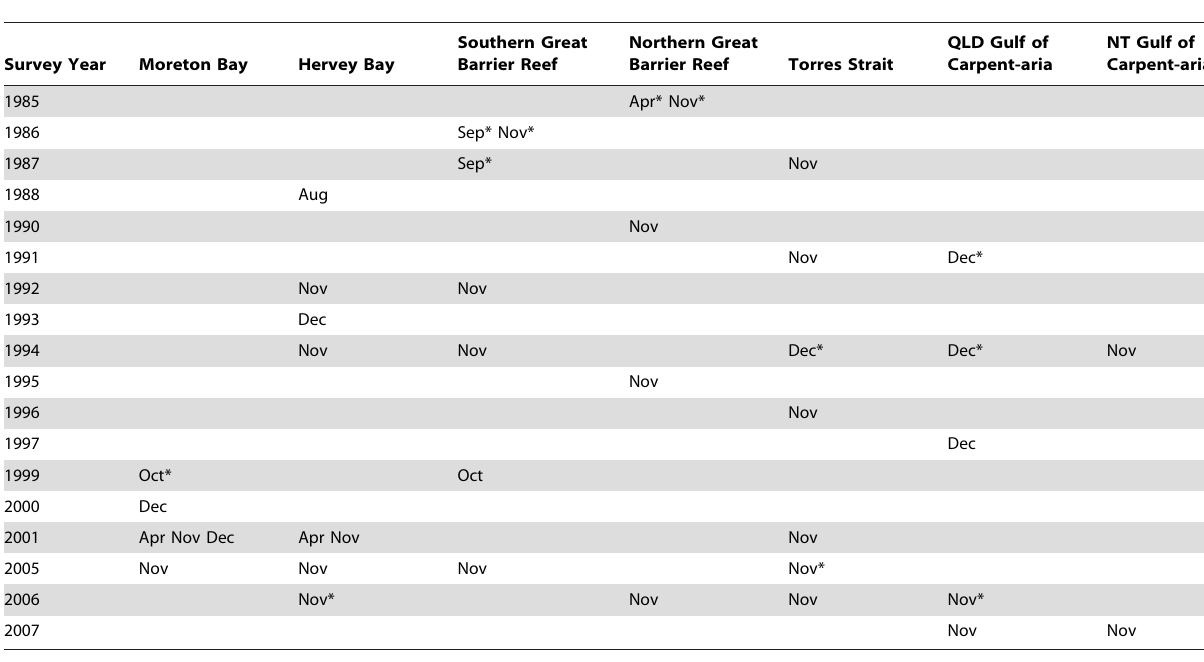
Table 1. Dugong aerial survey year and month 1 for the seven survey regions (Figure 1).